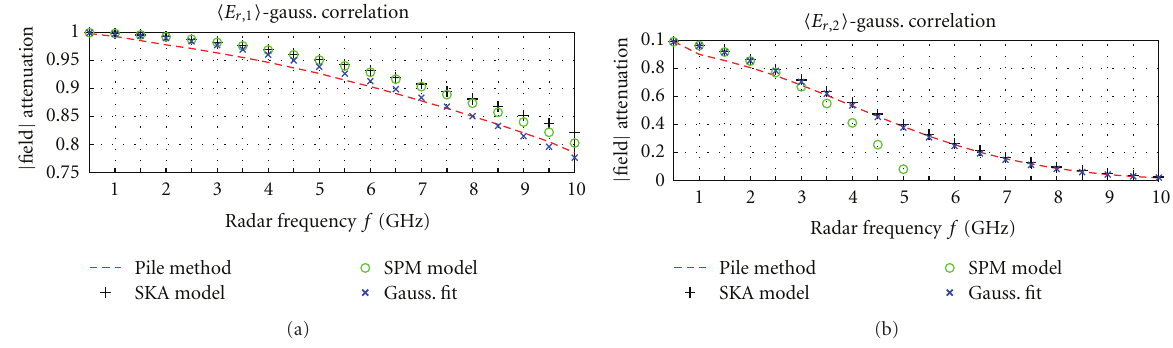
Figure 8: Frequency behavior of the amplitude attenuation of the coherent scattered fields (cid:2) E r ,1 (cid:3) and (cid:2) E r ,2 (cid:3) (V polarization) in the frequency band f ∈ [0 . 5;10 . 0]GHz, comparatively to the flat case. Results from the PILE code and comparison with the SKA and SPM2 asymptotic models for Gaussian surfaces. The upper and lower correlation lengths are L c A = 6 . 4mm and L c B = 15 . 0mm, respectively, and the upper and lower RMS heights are σ h A = 1 . 5mm and σ h B = 3 . 0mm, respectively.